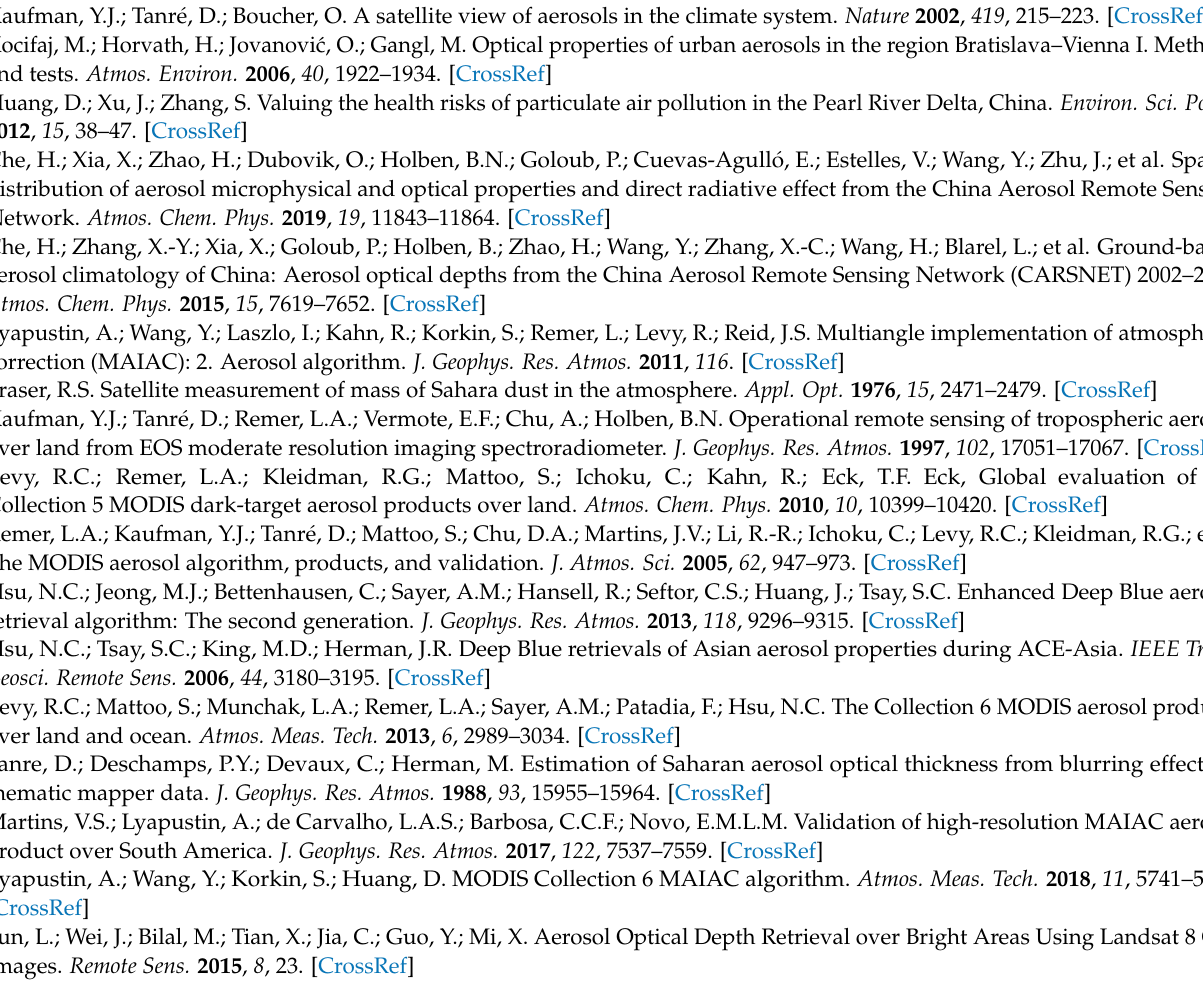
Figure A4. AOD retrievals from Landsat-8 (black dot) and Sentinel-2 (red dot) images on AERONET sites in the study period.